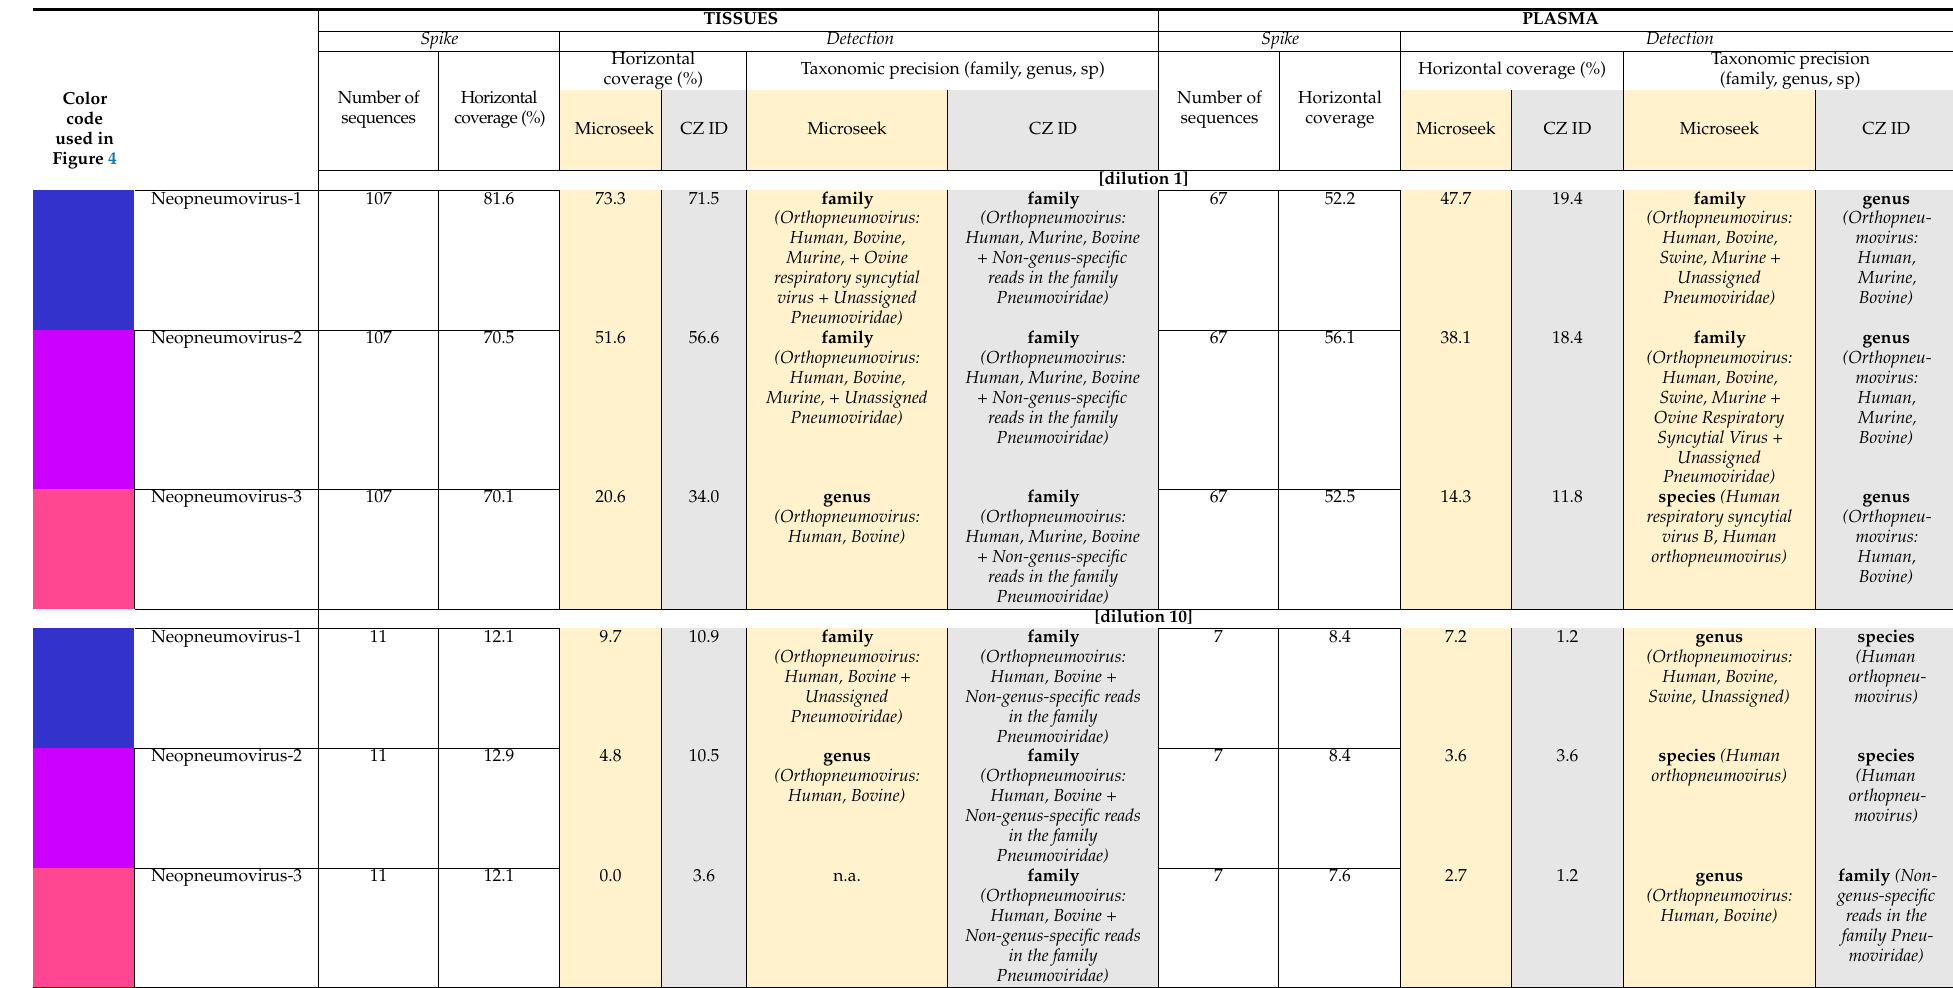
Table 2. Detection of Neopneumoviruses. The table represents the detection of spike vs. detected sequences of the three Neopneumoviruses at dilution 1 and dilution 10 in the Tissue and Plasma experiments. n.a.: not applicable. TISSUES PLASMA Spike Detection Spike Detection Taxonomic precision (family, genus, sp) Horizontal coverage (%) Taxonomic precision (family, genus, Number of Horizontal sequences coverage